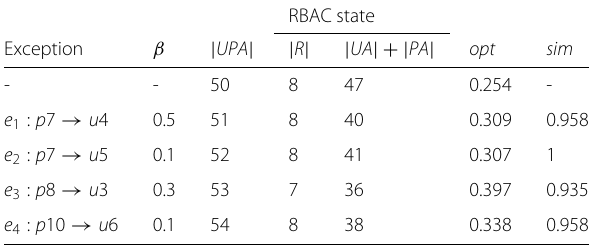
Table 3 List of exceptions to incorporate in the working example RBAC